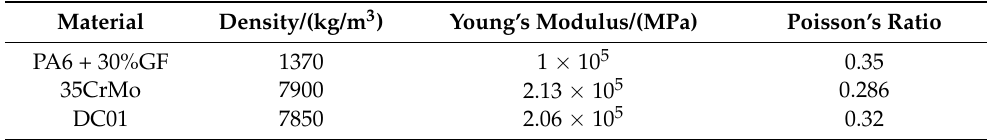
Table 7. The material parameters.